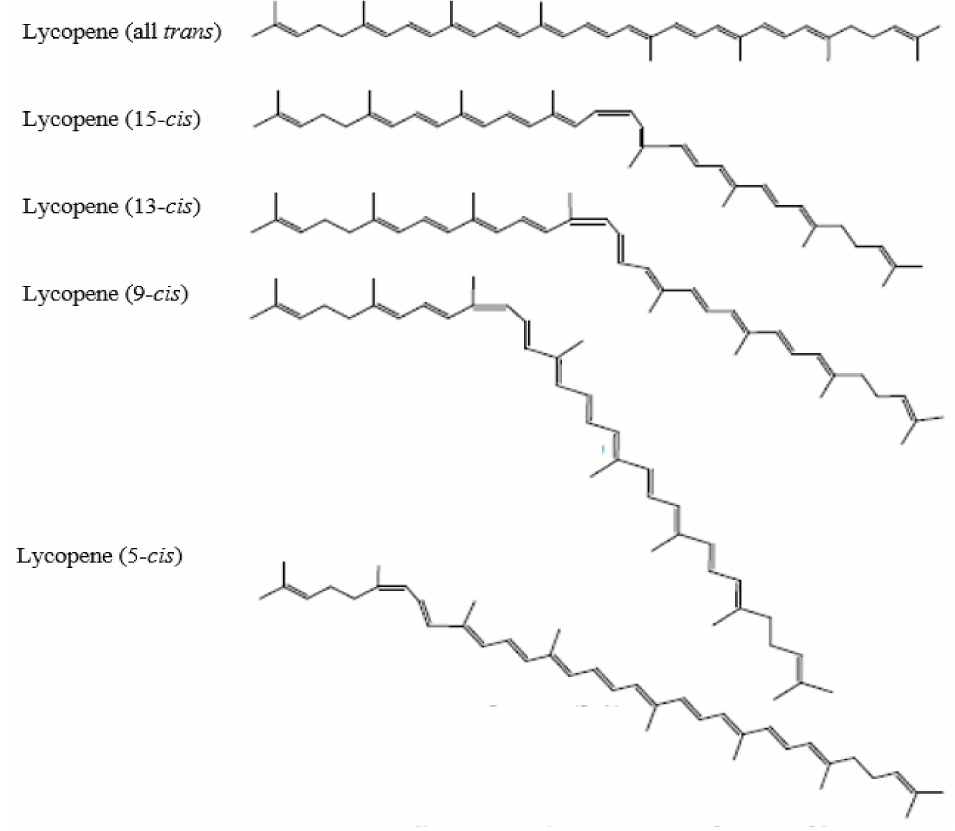
Figure 1. Chemical structure of lycopene